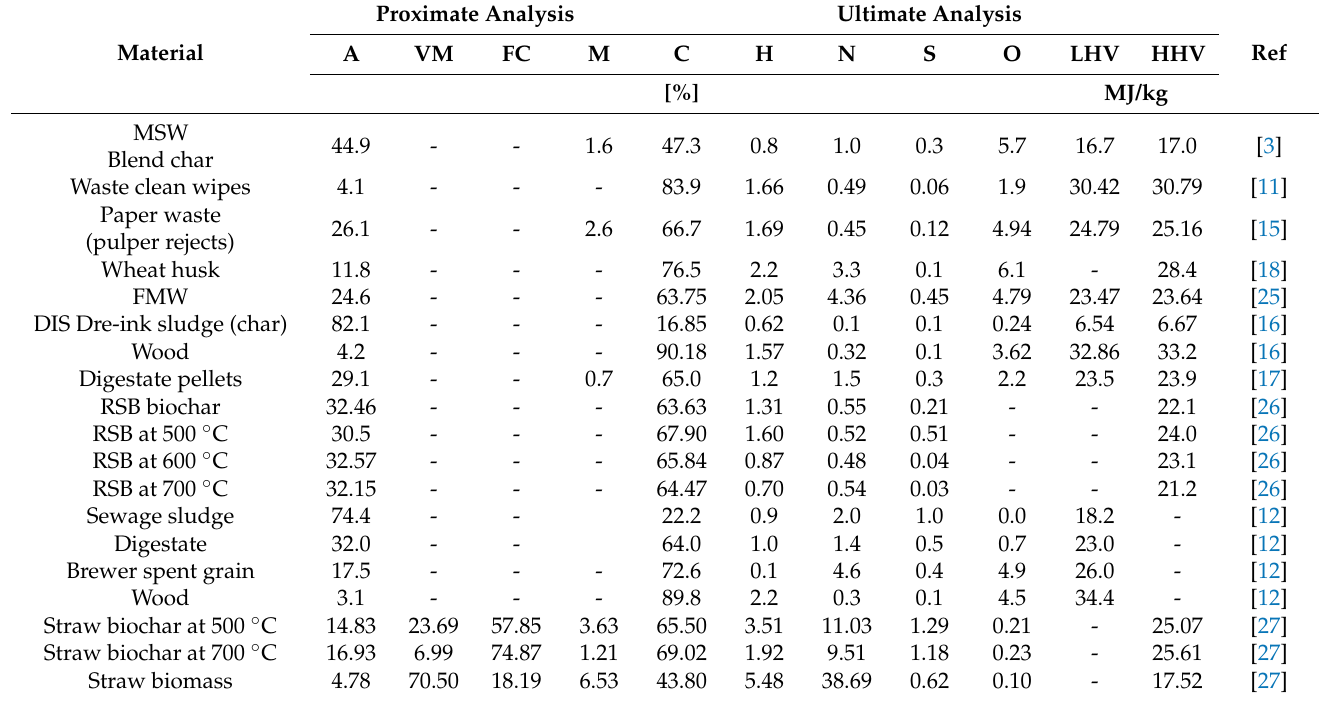
Table 1. Properties of various chars from TCR technology.